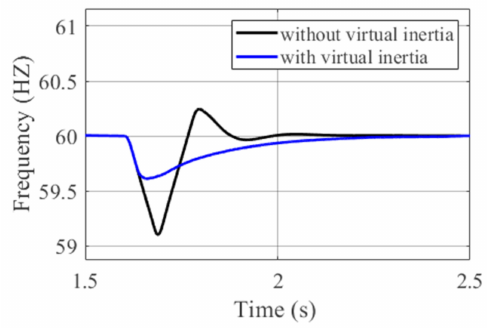
Figure 22. System frequency with and without virtual